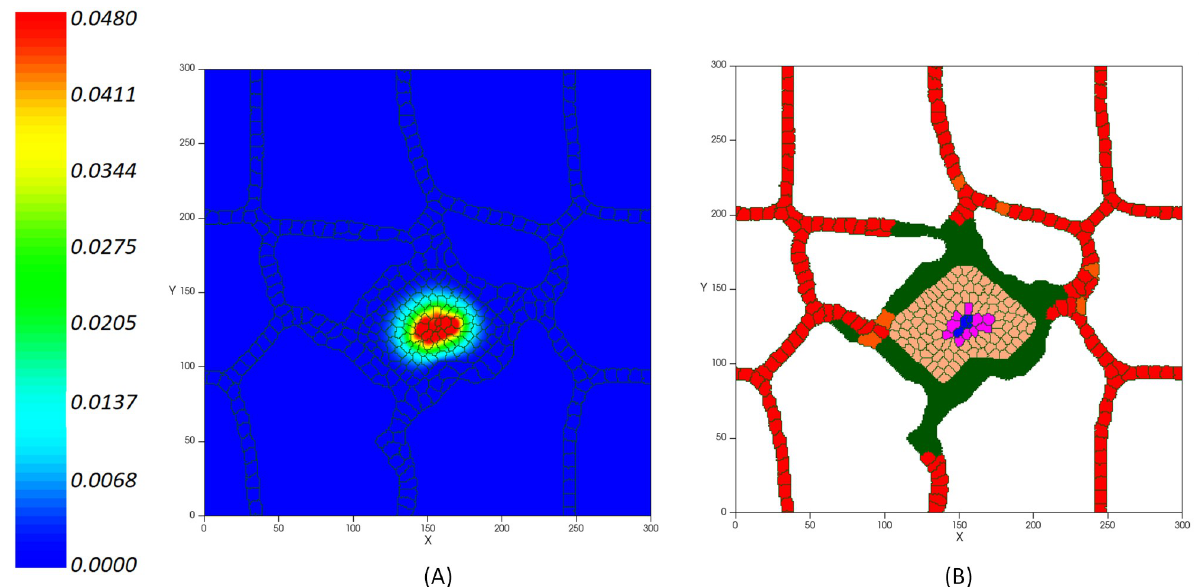
Fig 8. (A) Concentration of VEGF (in pg/cell/s) released from the tumor hypoxic core inducing the activation of ECs on day 12. (B) Activated ECs (in green) move through chemotaxis up the gradients of VEGF.